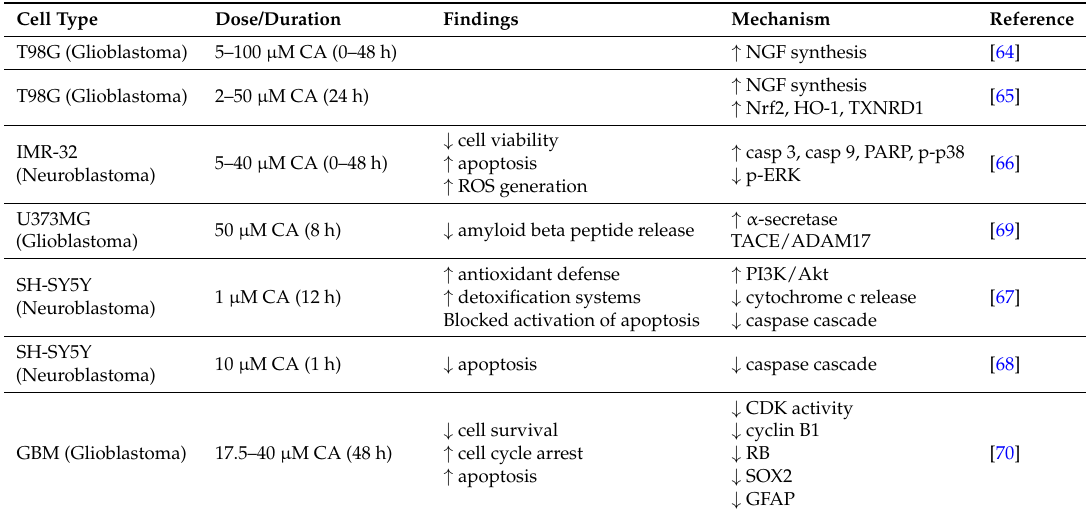
Table 10. Anticancer effects of Carnosic Acid (CA). In vitro studies: brain and neural